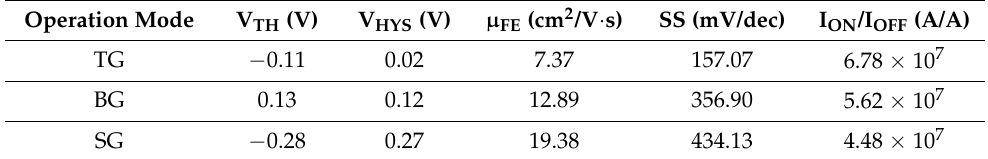
Table 2. Electrical parameters of triple-gate a-IGZO TFTs under top gate, bottom gate, and side gate operations.